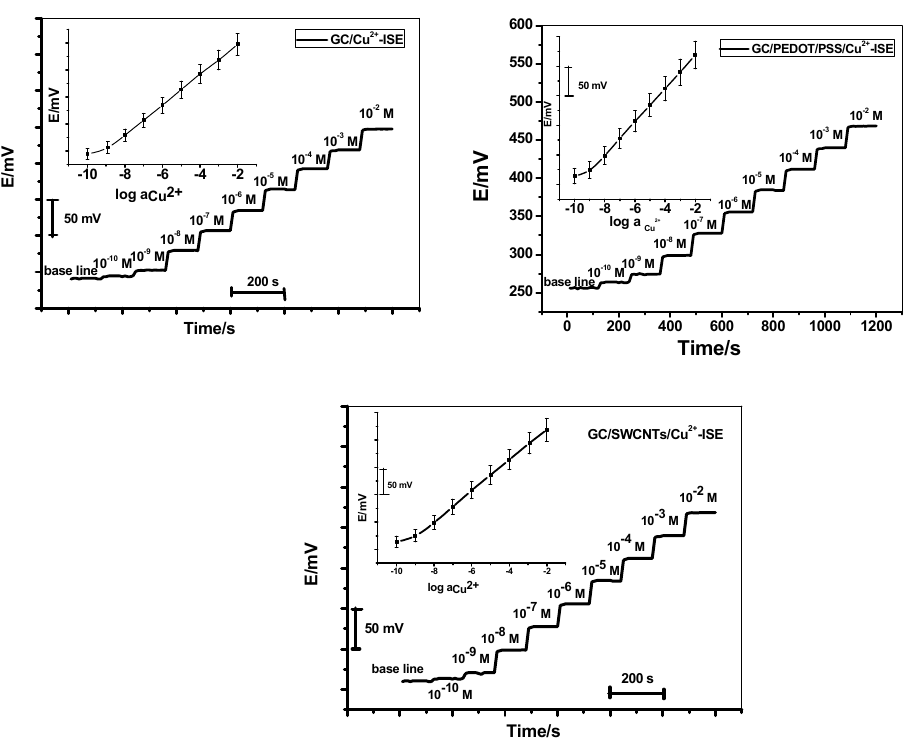
Figure 3. Recorded potential time traces for the proposed Cu 2+ -ISEs. The inset shows the corresponding calibration curves.